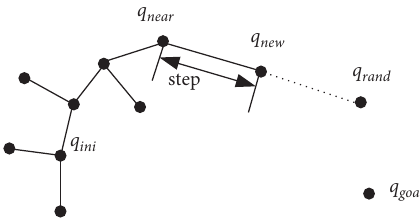
Figure 1: Basic RRT algorithm expansion process.